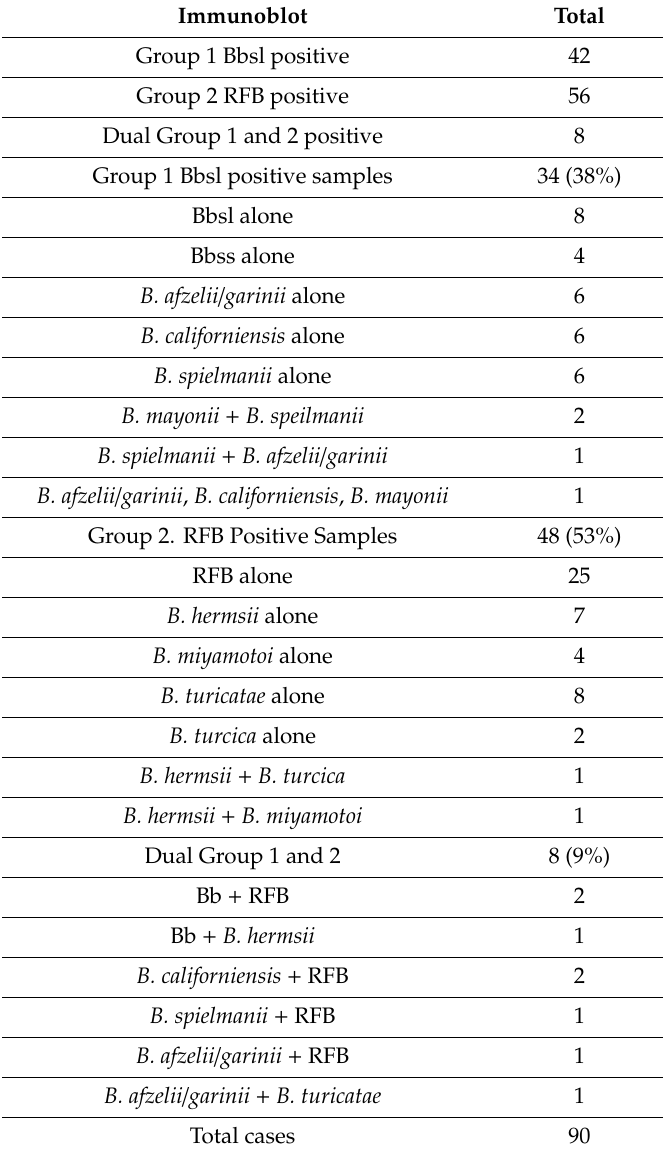
Table A2. Summary of seroreactivity for subjects in Group 1 (Bbsl), Group 2 (RFB), or